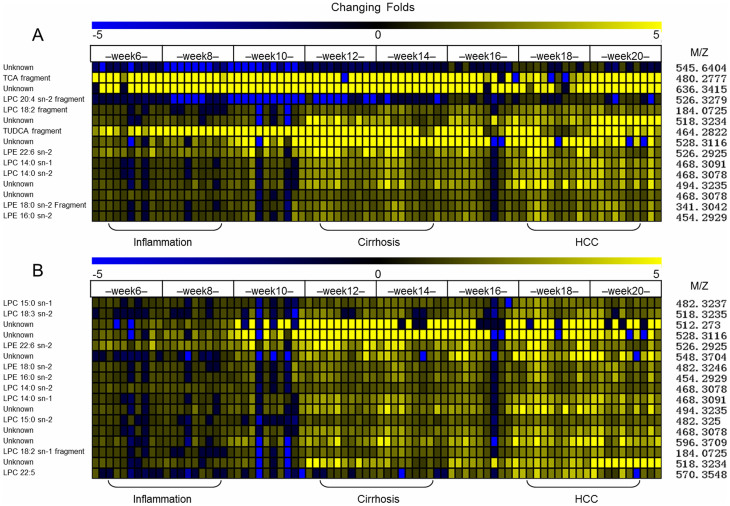
Top 20 features ranked by wRDA for discriminating liver diseases from healthy control (A) and HCC from non-HCC stages (B).Redundant ions from the same compound are deleted. LPC: lysophosphatidylcholine, TCA: taurocholic acid, TUDCA: tauroursodeoxycholic acid, LPE: lysophosphatidylethanolamine.